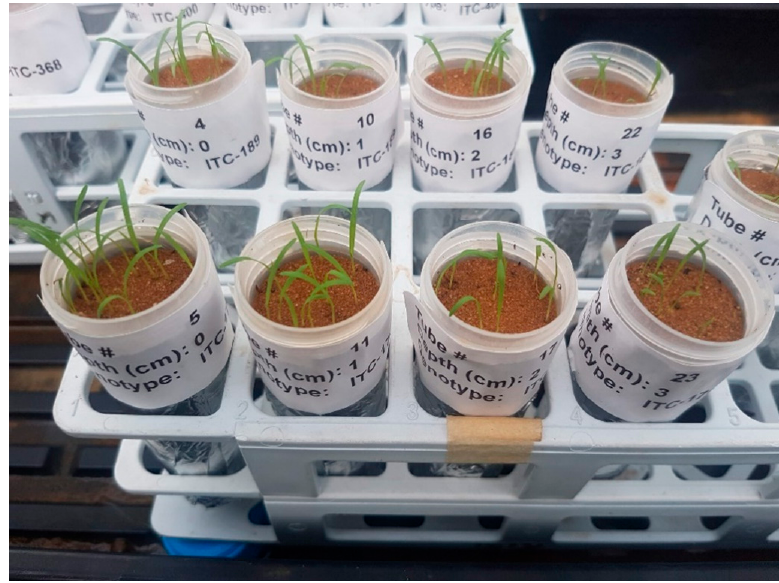
Figure 1. Tef seedlings sown in 50 mL tubes at depths of (left to right) 0, 1, 2, 3 cm 144 h after sowing.